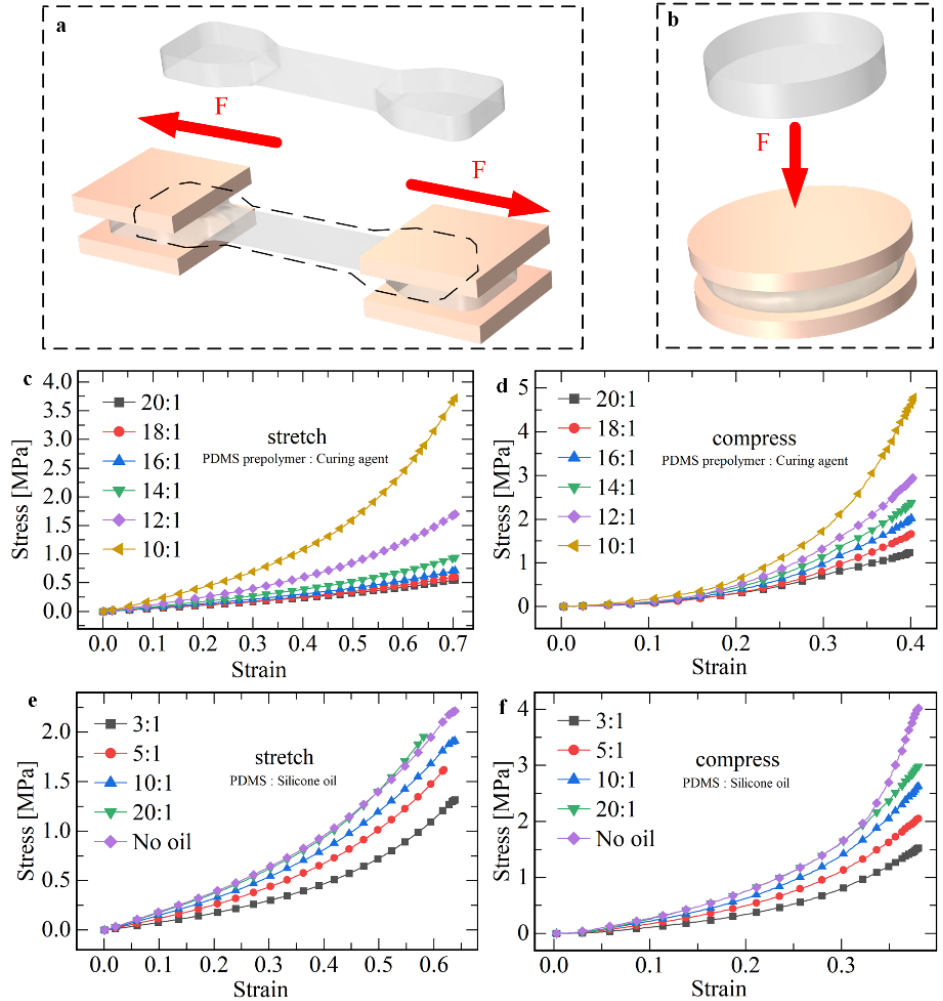
Figure 2. The effects of the content of curing agent and dimethyl silicone oil on the physical properties of PDMS are experimentally studied. The elastic modulus of the flexible material is tested and the stress-strain curve of PDMS is plotted. ( a ) Measuring the tensile properties of flexible materials. ( b ) Measuring the compressive properties of flexible materials. ( c ) Real tensile stress–strain curves of PDMS under different curing agent ratios. ( d ) Real compressive stress–strain curves of PDMS under different curing agent ratios. ( e ) Real tensile stress–strain curves of PDMS under different polydimethylsiloxane ratios. ( f ) Real compressive stress–strain curves of PDMS under different polydimethylsiloxane ratios. The data measured by the test machine are the load F and displacement x during tension or compression. The nominal strain ε m and nominal stress σ m are calculated as shown in Equations (1) and (2), while real strain ε z and real stress σ z are calculated by Equations (3) and (4). Through the measurement system of the experimental machine,